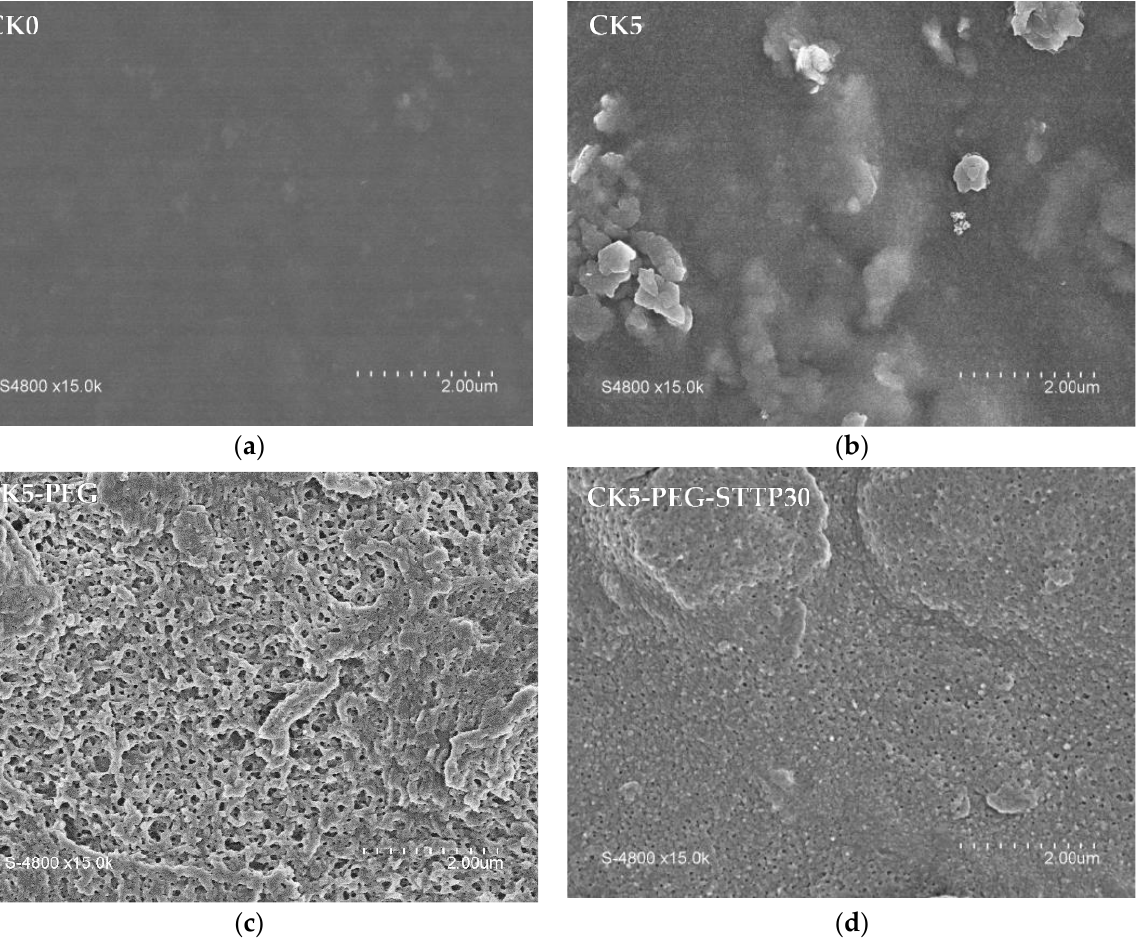
Figure 1. SEM pictures of the membrane surface (magnification × 15,000): ( a ) CK0, pristine chitosan membrane; ( b ) CK5, chitosan/kaolin composite membrane; ( c ) CK5-PEG, with PEG as a pore former; and ( d ) CK5-PEG-STPP30, cross-linked membranes (reaction time, 30 min).